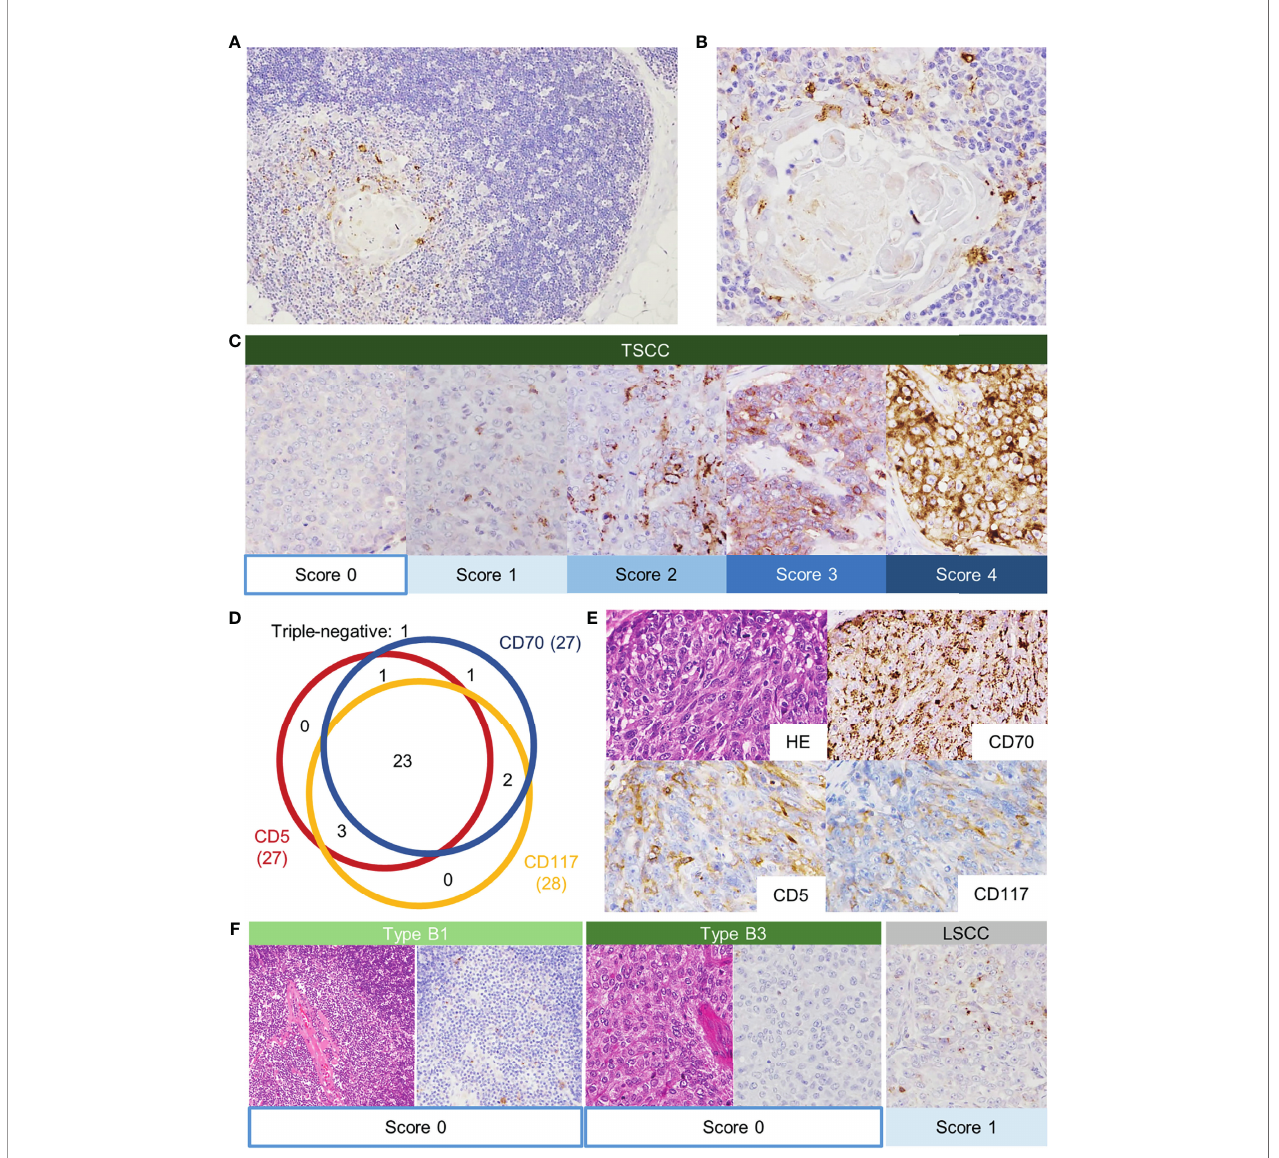
FIGURE 1 | Normal adult thymus tissue stained with anti-CD70 antibody. Thymic medullary epithelial cells or dendritic cells were positive for CD70 (A, B) . Immunostaining of CD70 in thymic squamous cell carcinoma (TSCC) (C) . CD70-positivity was scored according to the proportion of positive tumor cells (score 0: <1%; score 1: 1 – 24%; score 2: 25 – 49%; score 3: 50 – 74%; score 4: 75 – 100%). Schematic summary of immunohistochemical analysis (D).The numbers indicate the positive cases of each staining. The numbers in the parentheses are the total number of the positive cases. Immunostaining of CD70 (score 4), CD5 and CD117 in TSCC (E) . In contrast, thymoma showed the absence of CD70 expression (F) . The CD70 score in lung squamous cell carcinoma was relatively